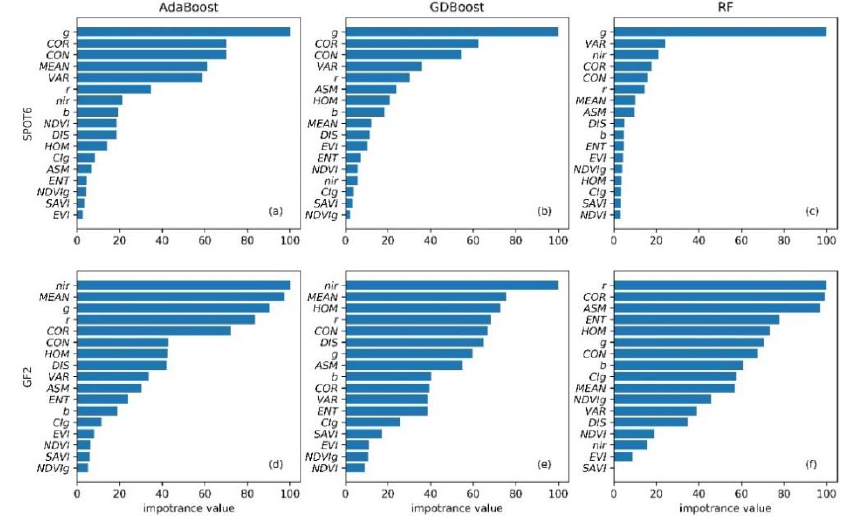
Figure 3. Relative importance value (RIV) of di ff erent AdaBoost, GDBoost and RF models in SPOT and GF2 ( a ) RIV based on AdaBoost in SPOT6 ( b ) RIV based on GDBoost in SPOT6 ( c ) RIV based on RF in SPOT6 ( d ) RIV based on AdaBoost in GF2 ( e ) RIV based on GDBoost in GF2 ( f ) RIV based on RF in GF2. ( b , g, r , and nir represent reflectance in the blue, green, red, and near-infrared wavelengths, respectively, NDVI,NDVIg, CIg, EVI, and SAVI represent vegetation indices, MEAN,HOM, CON, DIS, ENT, VAR, ASM , and COR represent texture parameters derived from gray level co-occurrence matrix (GLCM)